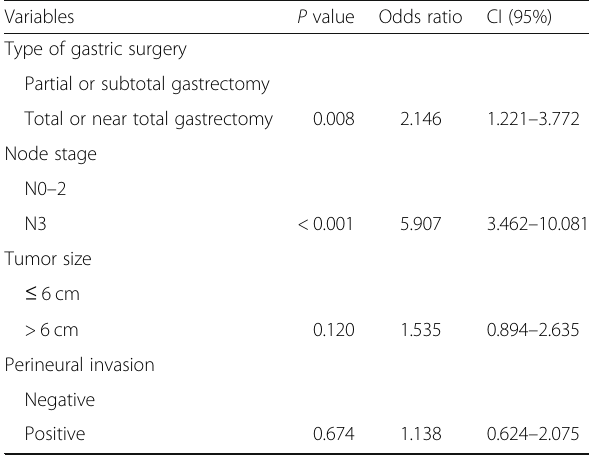
Table 4 Independent variables associated with adequate ( ≥ 16) lymph node assessment in resected gastric adenocarcinoma